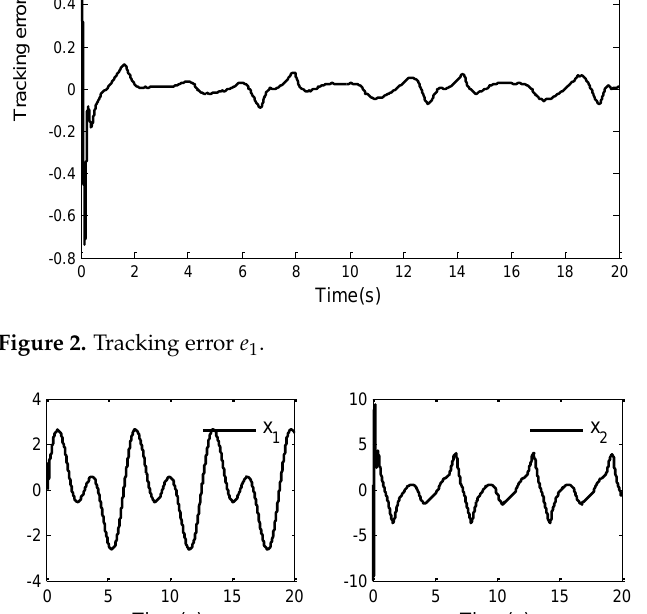
Figure 3. System states x 1 , x 2 and x 3